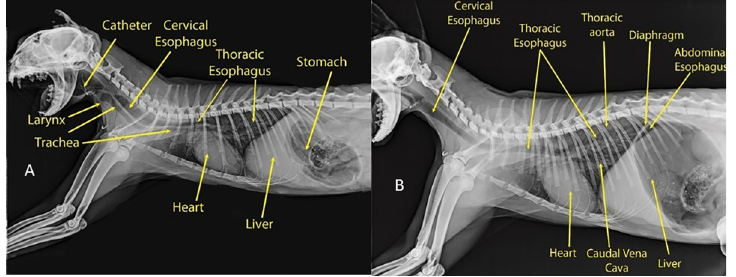
Fig 6. Negative contrast radiograph of a cat oesophagus. a) Left lateral view of a negative contrast radiograph of a cat oesophagus, showing its anatomy (visible Trachea). b) Left lateral view of a negative contrast radiograph of a cat oesophagus, showing its anatomy (visible Abdominal oesophagus and thoracic aorta).